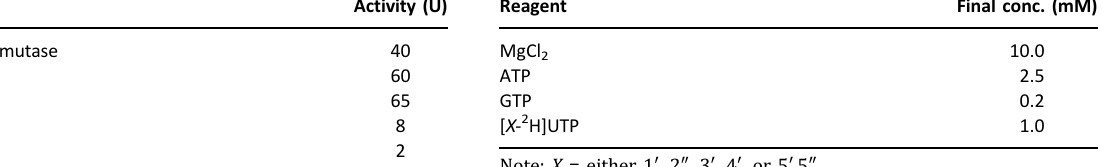
Table 10. Enzymes for ATP, GTP, and UTP synthesis. Enzyme